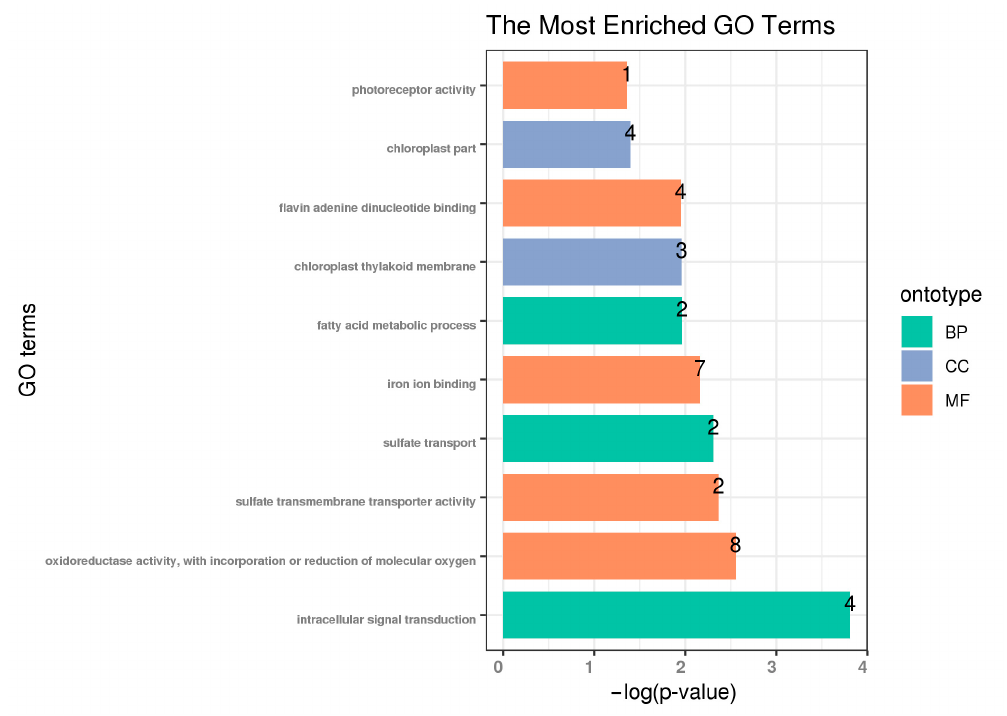
Figure 5. Gene Ontology (GO) enrichment analysis of potential target genes (PTGs) of di ff erently expressed lncRNAs in allotetraploid S14 compared with parents / MPV. Shown are significantly enriched GO terms (top10, p -value < 0.05). The label at the top of the bar represents the number of genes. BP, biological process; MF, molecular function; CC, cellular